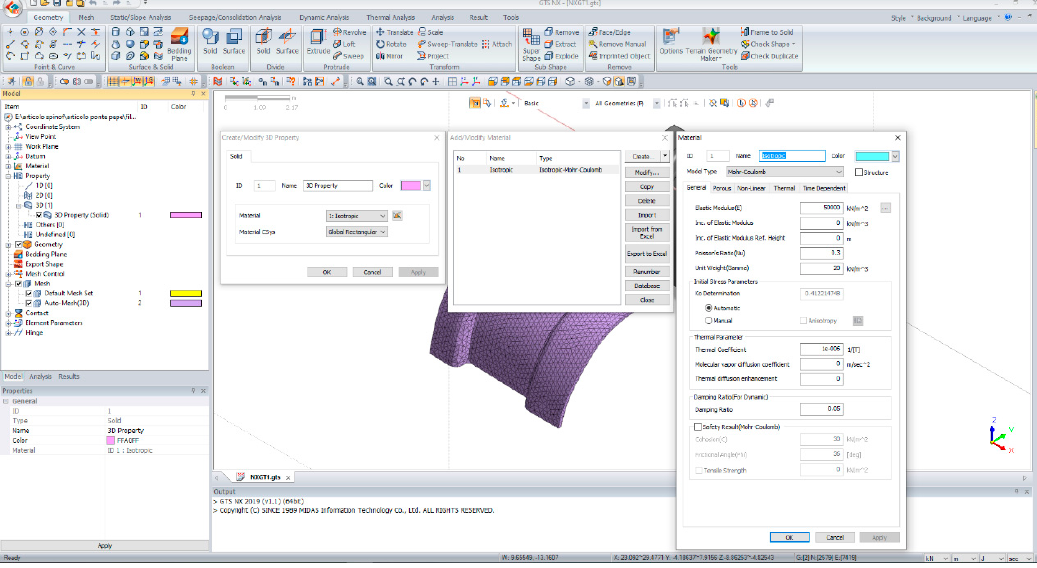
Figure 16. Materials and constitutive relation assigned to the masonry arch of the bridge in Midas GTS NX software.